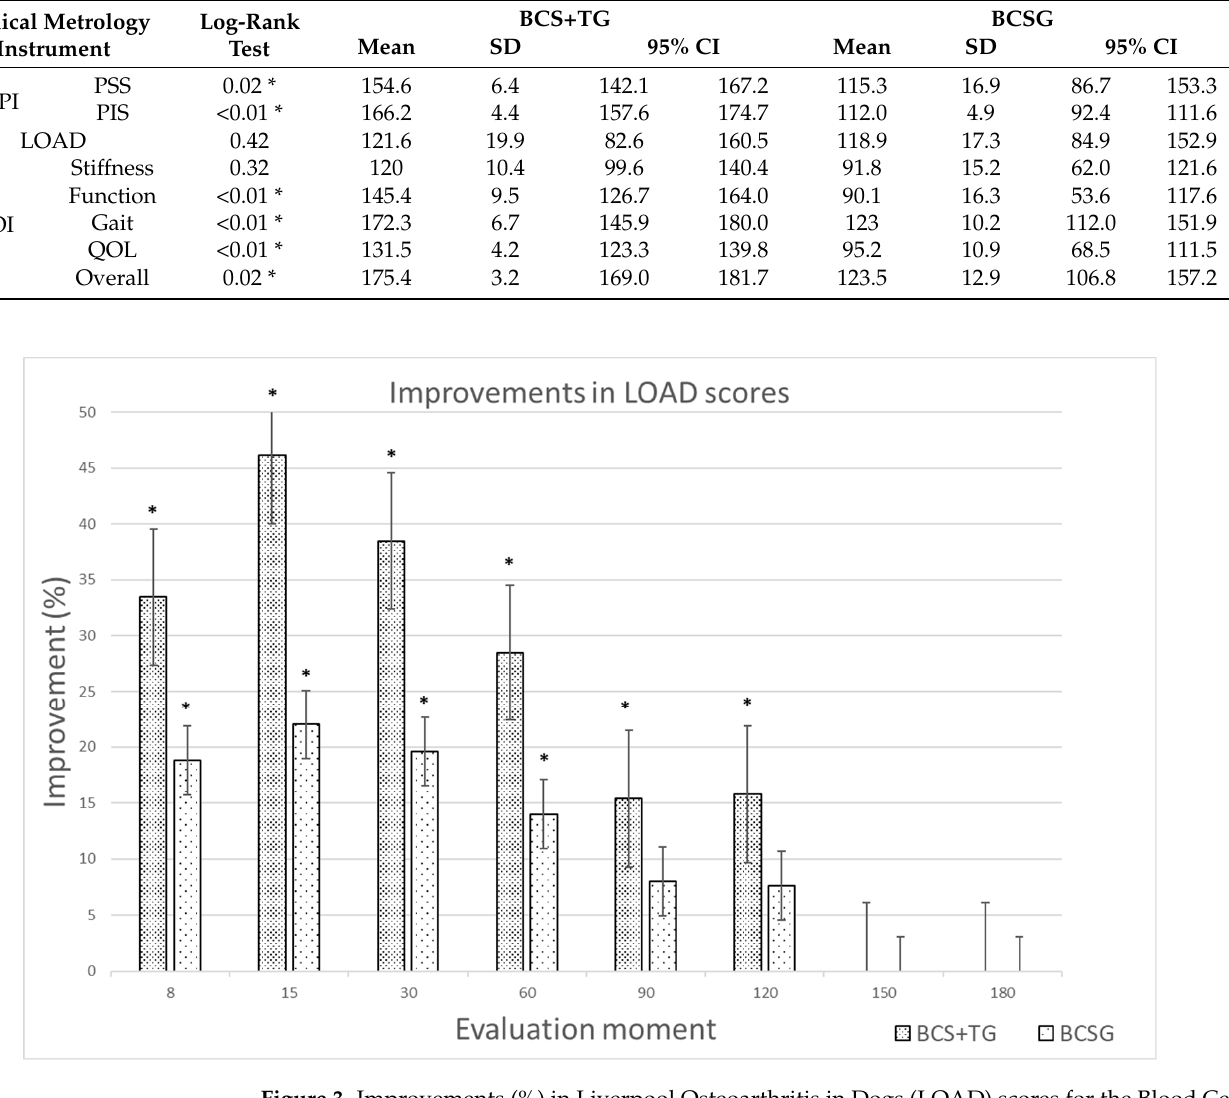
Table 2. Time-to-event (in days) for the clinical metrology instruments considered in the Blood Cell Secretome + triamcinolone group (BCS+TG) and Blood Cell Secretome group (BCSG), calculated with Kaplan–Meier estimators and compared with the logrank test. Events considered were a score change below the improvement level set as clinically significant for each score: ≥ 1 in PSS, ≥ 2 in PIS [33], ≥ 4 in LOAD [34], ≥ 3.5 in COI [34], or when an improved score, compared to baseline values, was no longer observed for stiffness, function gait, and QOL. Legend: CBPI—Canine Brief Pain In- ventory; CI – Confidence interval; COI—Canine Orthopedic Index; LOAD—Liverpool Osteoarthri- tis in Dogs; PIS—Pain Interference Score; PSS—Pain Severity Score; QOL—Quality of Life. * indi- cates significance. Clinical Metrology Instrument